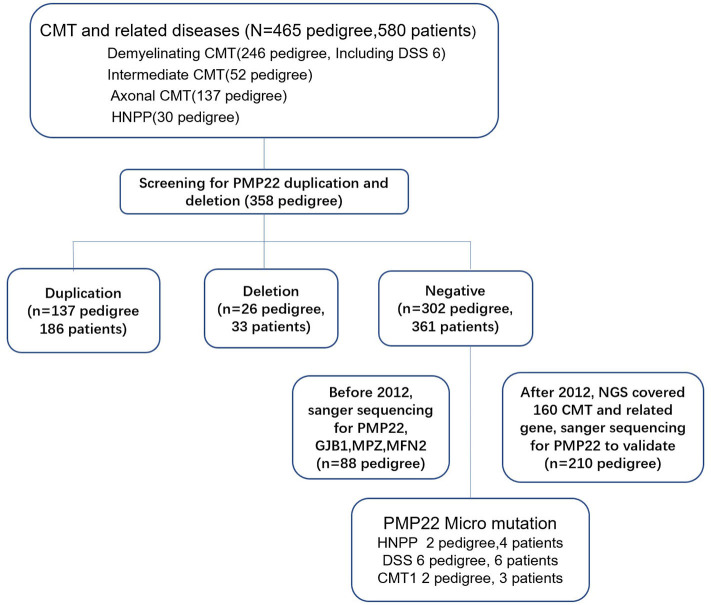
Genetic testing flow chart for patients with CMT disease and HNPP.